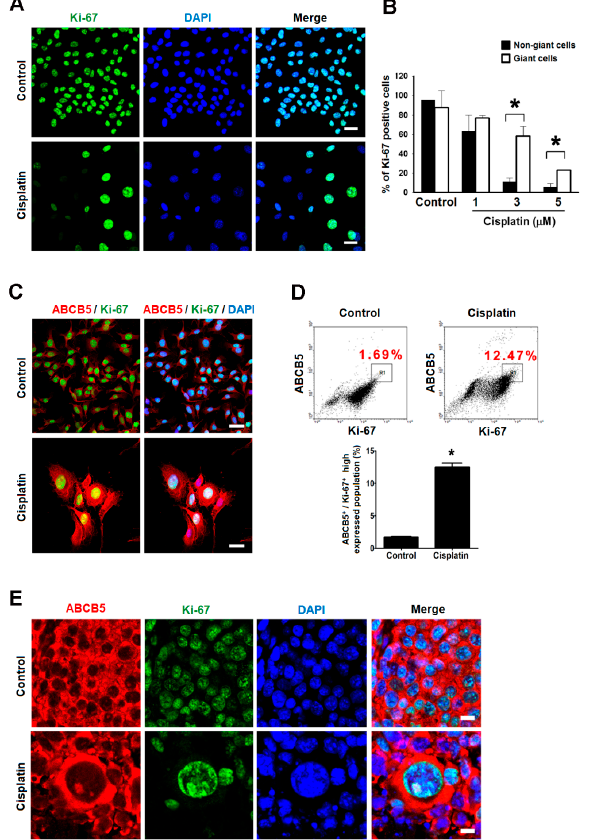
Figure 5. The expressions of Ki-67 and ABCB5 were detected by immunofluorescence after cisplatin treatment in vitro and in vivo. The proliferating maker Ki-67(green), ABCB5 (red) were co-immunostained with their respective antibodies; the nuclei were stained with DAPI (blue). ( A , C , D ) The in vitro evidence was obtained from B16-F10 cells that were treated with 3 μ M cisplatin for 48 h. ( A ) The expression of Ki-67 was sustained in giant cells after cisplatin treatment. Scale bar, 50 μ m. ( B ) The percentage of Ki-67 expression in the non-giant cells and the giant cells. * p < 0.05, compared with the non-giant cells treated with the same dose of cisplatin. ( C ) The co-expressions of Ki-67 and ABCB5 in control and cisplatin-treated B16-F10 cells. Scale bar, 50 μ m. ( D ) The expressions of ABCB5 and Ki-67 were analyzed by flow cytometry (upper panel), and the top region of the ABCB5 and Ki-67 signals were gated for the quantification of the population that strongly co-express ABCB5 and Ki-67 (lower panel). The percentages of ABCB5 + /Ki-67 + high expressed population indicated on the panel are the means of three independent experiments. * p < 0.01 compared with the control cells. ( E ) The cellular distribution of ABCB5 and Ki-67 in tissue specimens of control and cisplatin-treated tumor-burdened mice. Scale bar, 10 μ m.